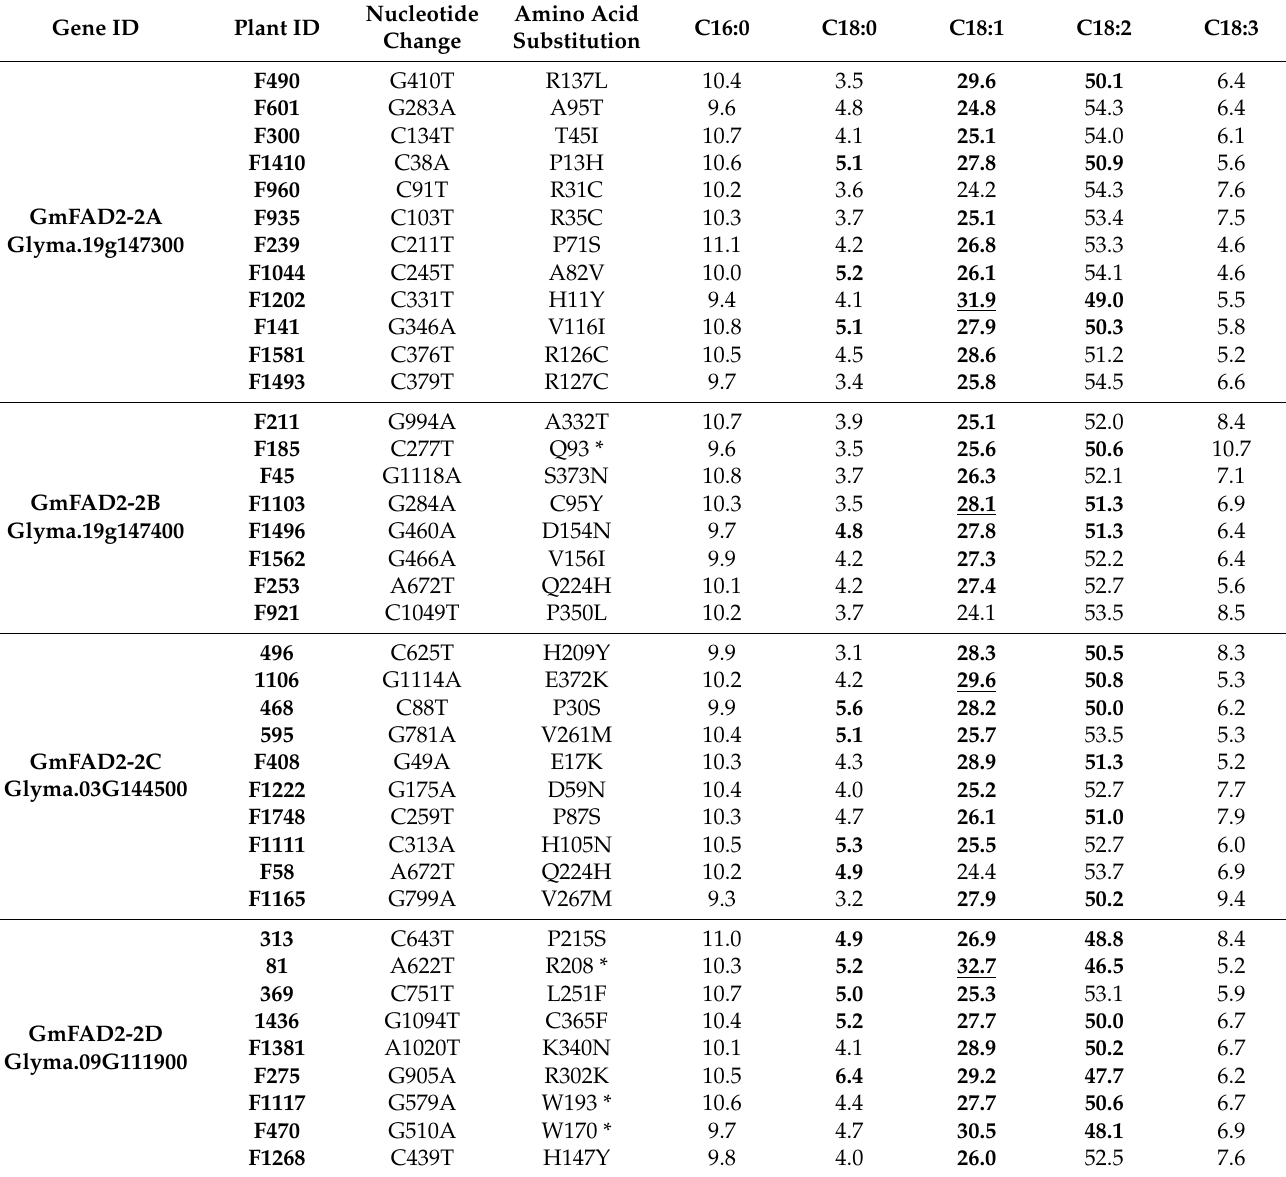
Table 2. All 58 isolated EMS Gmfad2-2 TILLING mutants showing increase in the seed oleic acid content. Gene ID Plant